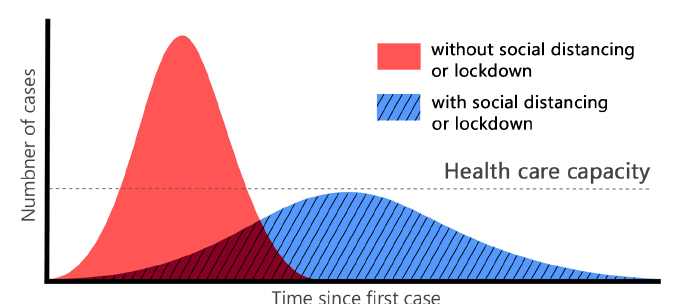
Figure 2. Gaussian distribution of infection transmission rate for a given population, with and without social distancing